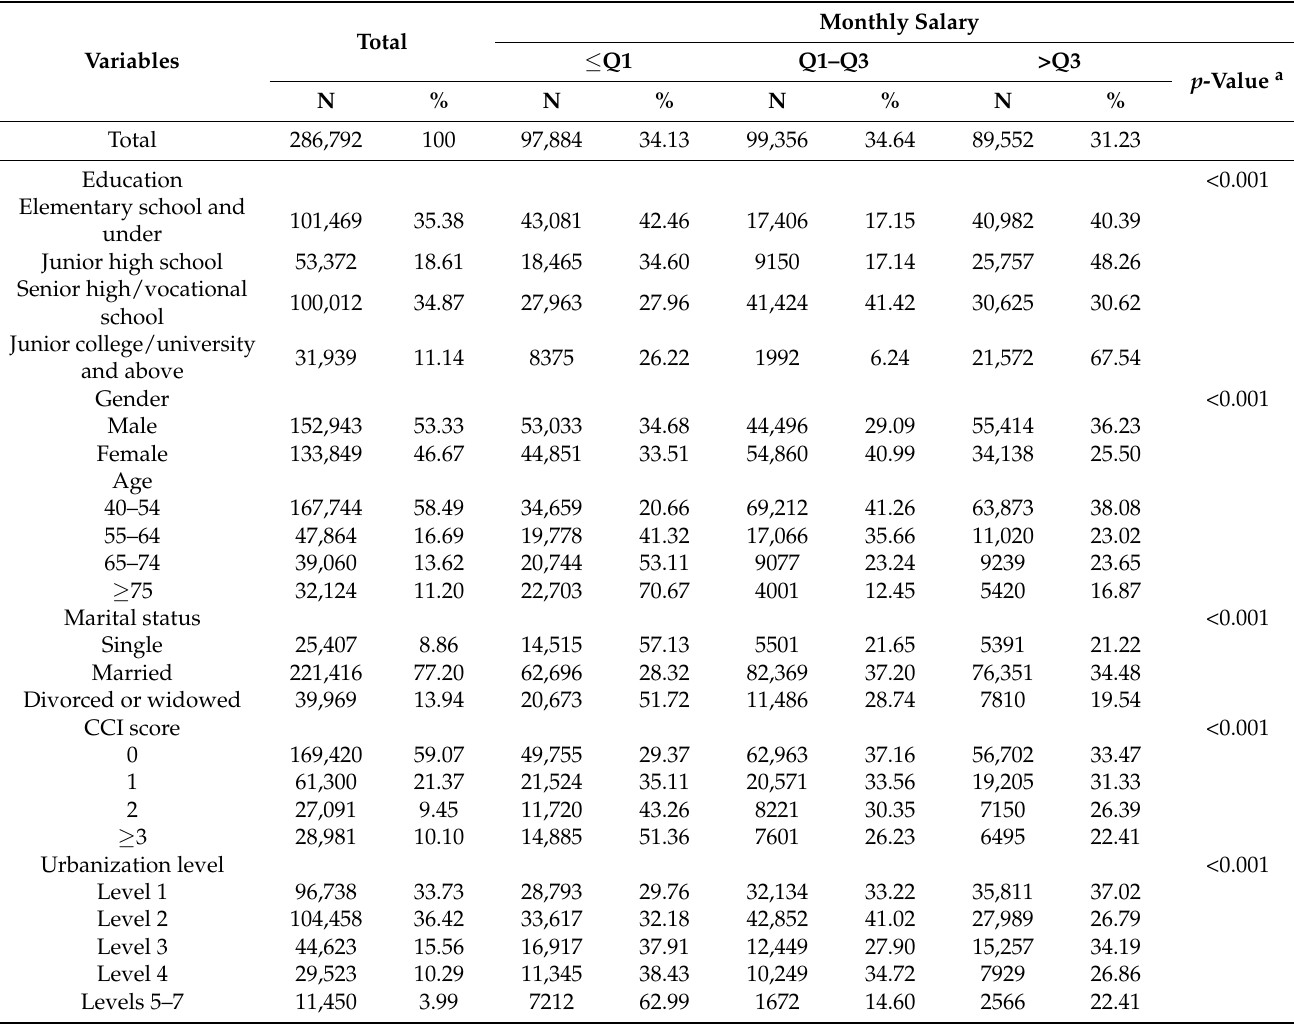
Table 1. Demographic characteristics of study participants in